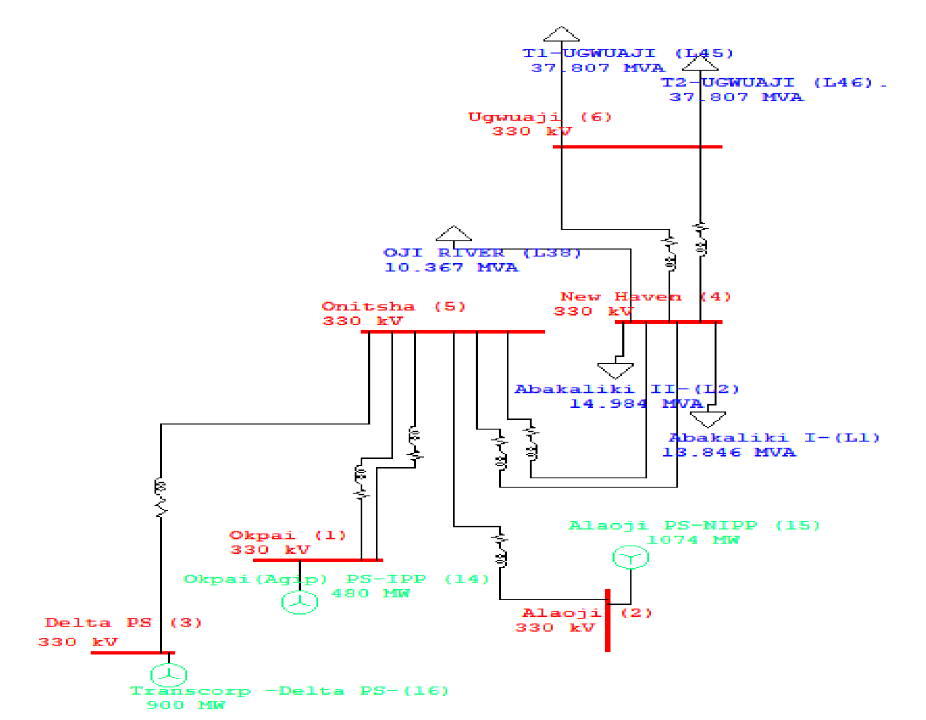
Figure 6. Nigerian 330 kV Eastern Grid Network